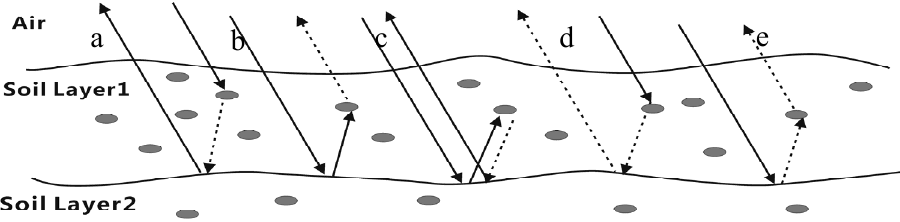
Figure 3. Representation of Radar backscatter interactions between soil layers, including downward scattering by soil particles (in gray) in the first layer or air-soil interface, (a) followed by coherent scattering from the first-second soil layer interface; coherent scattering by the first-second soil layer interface, (b) followed by incoherent scattering from particles inside the first layer or air-soil interface; coherent scattering by the first-second soil layer interface, (c) followed by particle scattering in the first layer and coherent scattering from the first-second layer interface; particle scattering in the first layer or air-soil interface, (d) followed by non-coherent scattering from the first-second soil layer interface; non-coherent scattering by the first-second soil layer interface, (e) followed by scattering from particles in the first layer or air-soil